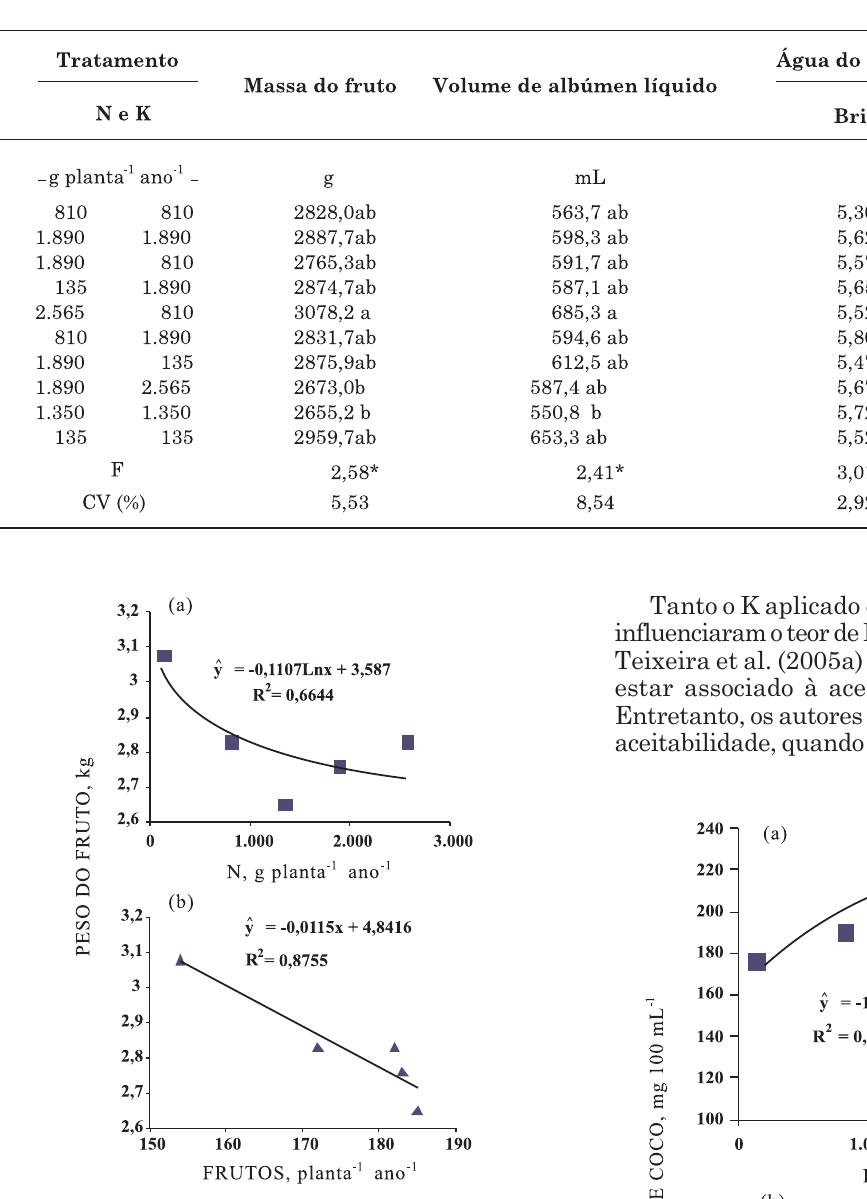
Figura 4. Massa do fruto de coqueiro-anão verde de seis anos de idade em função de doses de N (a) e do número de frutos por planta (b).